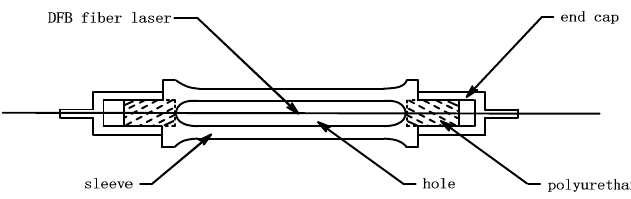
Figure 2. Design structure of polyurethane tensioned FLH.